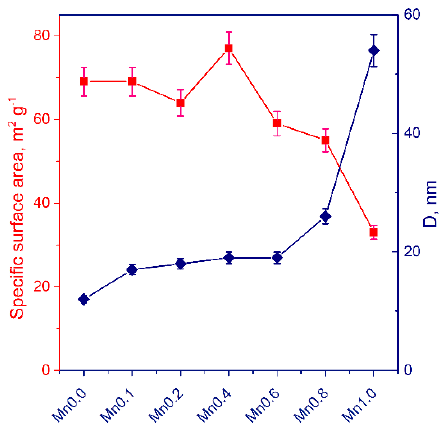
Figure 3. Textural characteristics, specific surface area and pore diameter (D), of the samples Mnx (x = 0–1.0).